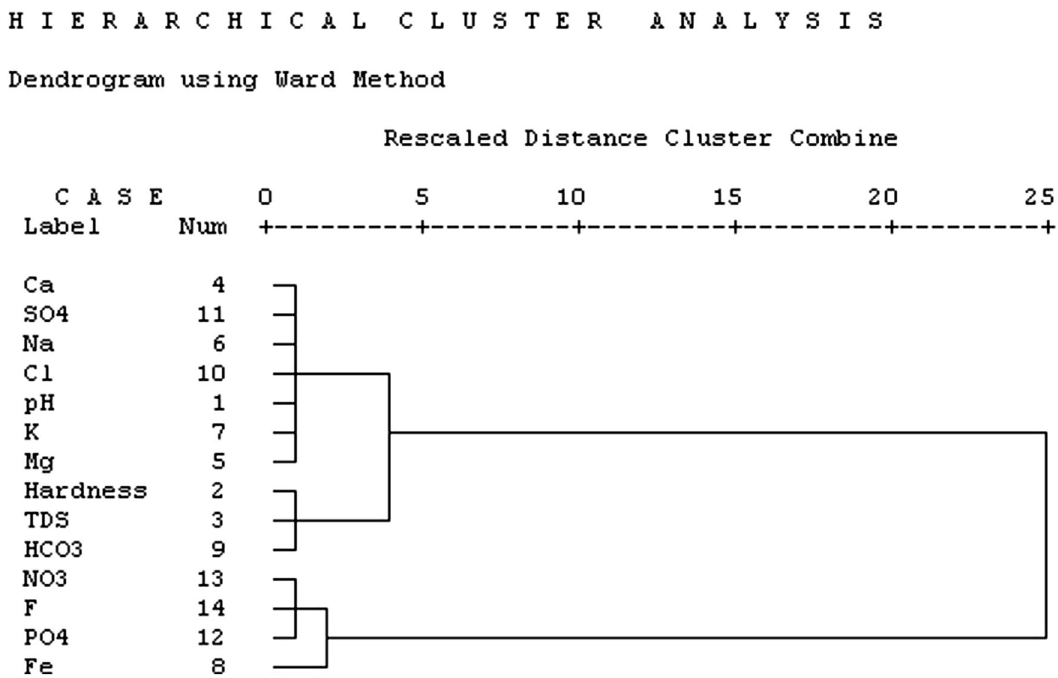
Fig. 7 Dendrogram of hierarchical cluster analysis of the selected aquifers in the wet season